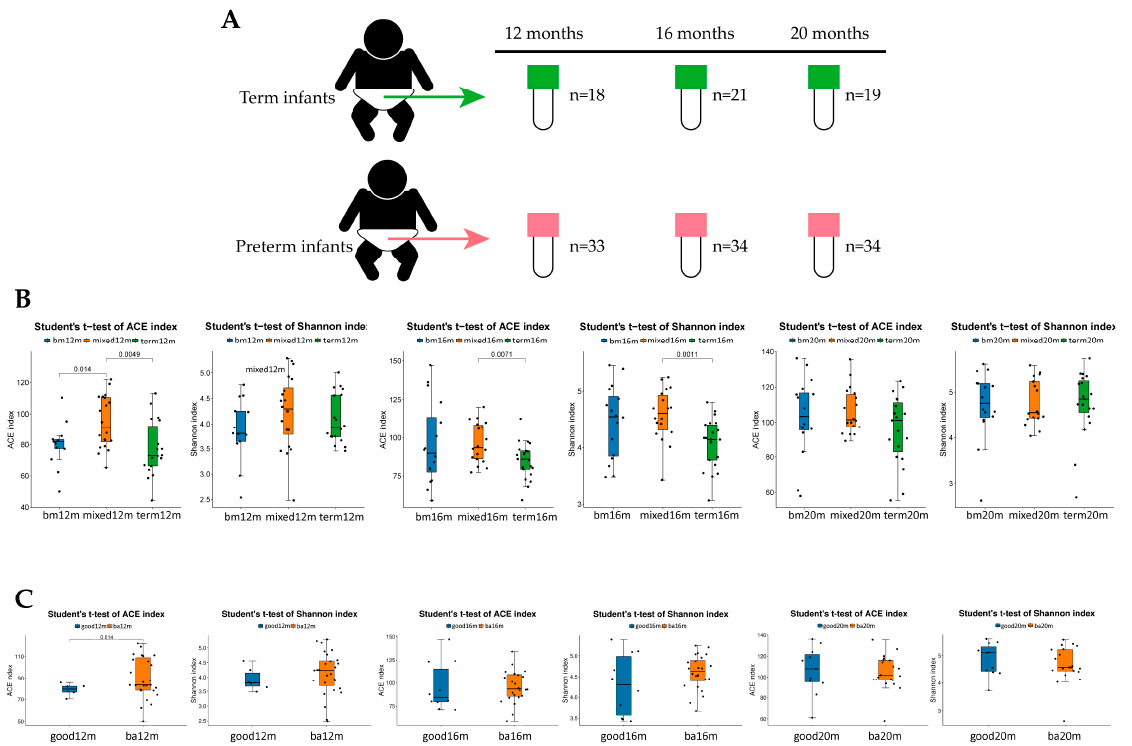
Figure 2. Alpha diversity of each group varied by feeding mode or neurodevelopment outcomes at different sampling times. ( A ) Total of 159 samples collecting at 12 months, 16 months and 20 months; ( B ) ACE index and Shannon index in each group varied by feeding mode at 12 months, 16 months and 20 months; ( C ) ACE index and Shannon index varied by language composite score at 12 months, 16 months and 20 months. Figure legend: bm, breast milk; ba, below average; m, months.